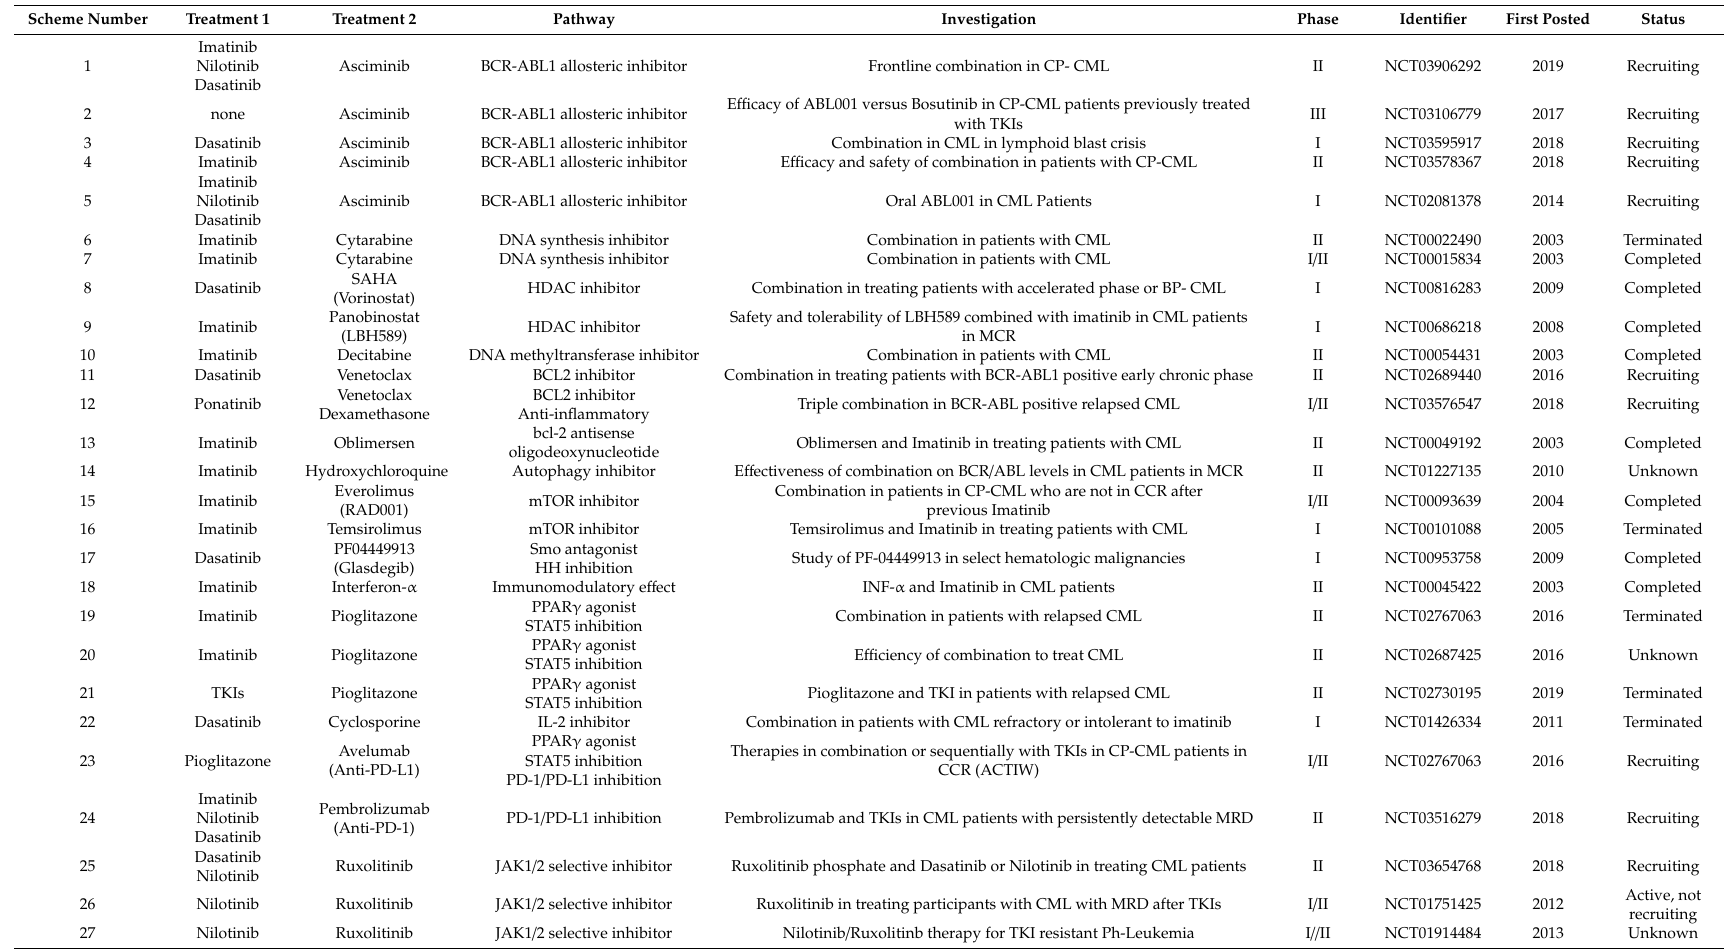
Table 2. Clinical Trials Involving CML Patients Treated either with Investigational Molecules in Combination with TKIs or